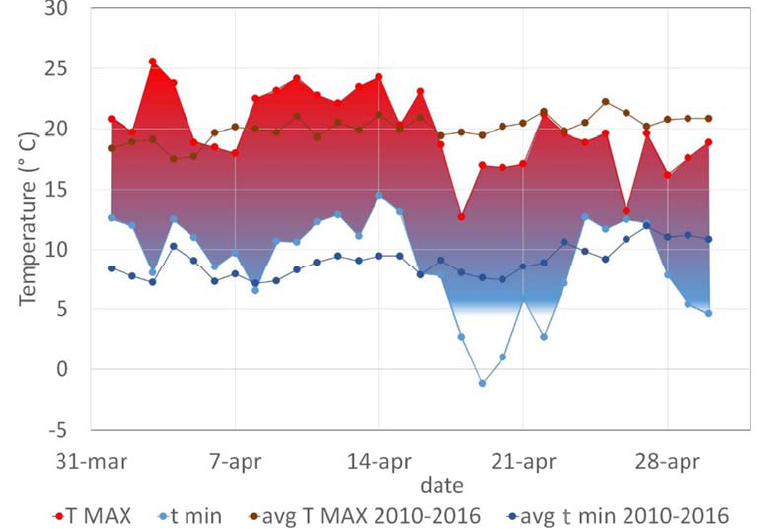
Figure 1. Curve of daily maximum and minimum temperature during the period April–June 2017